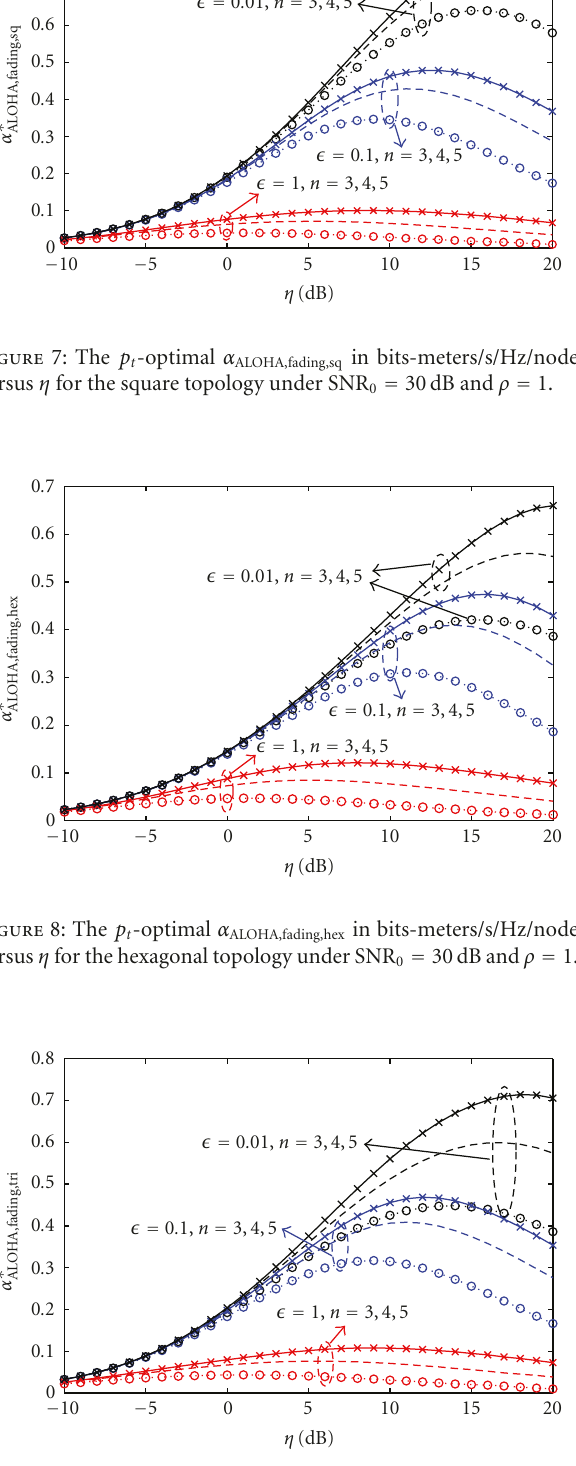
Figure 9: The p t -optimal α ALOHA,fading,tri in bits-meters/s/Hz/node versus η for the triangular topology under SNR 0 = 30dB and ρ =